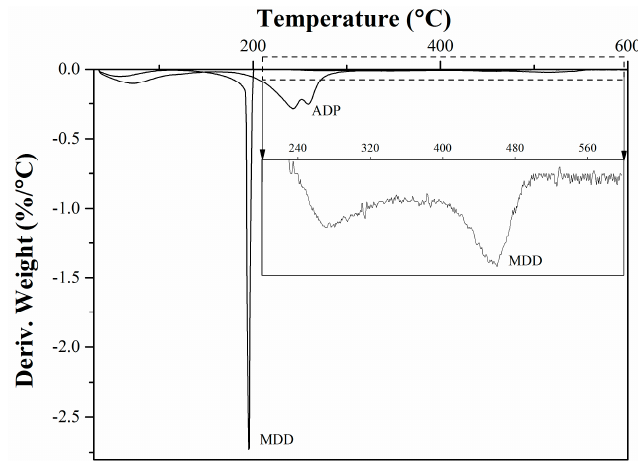
Figure 7. Differential thermogravimetric profiles of Cu/SBA-15 materials prepared by ADP and MDD methods with the enlargement of the 200–600 °C region for the MDD sample.